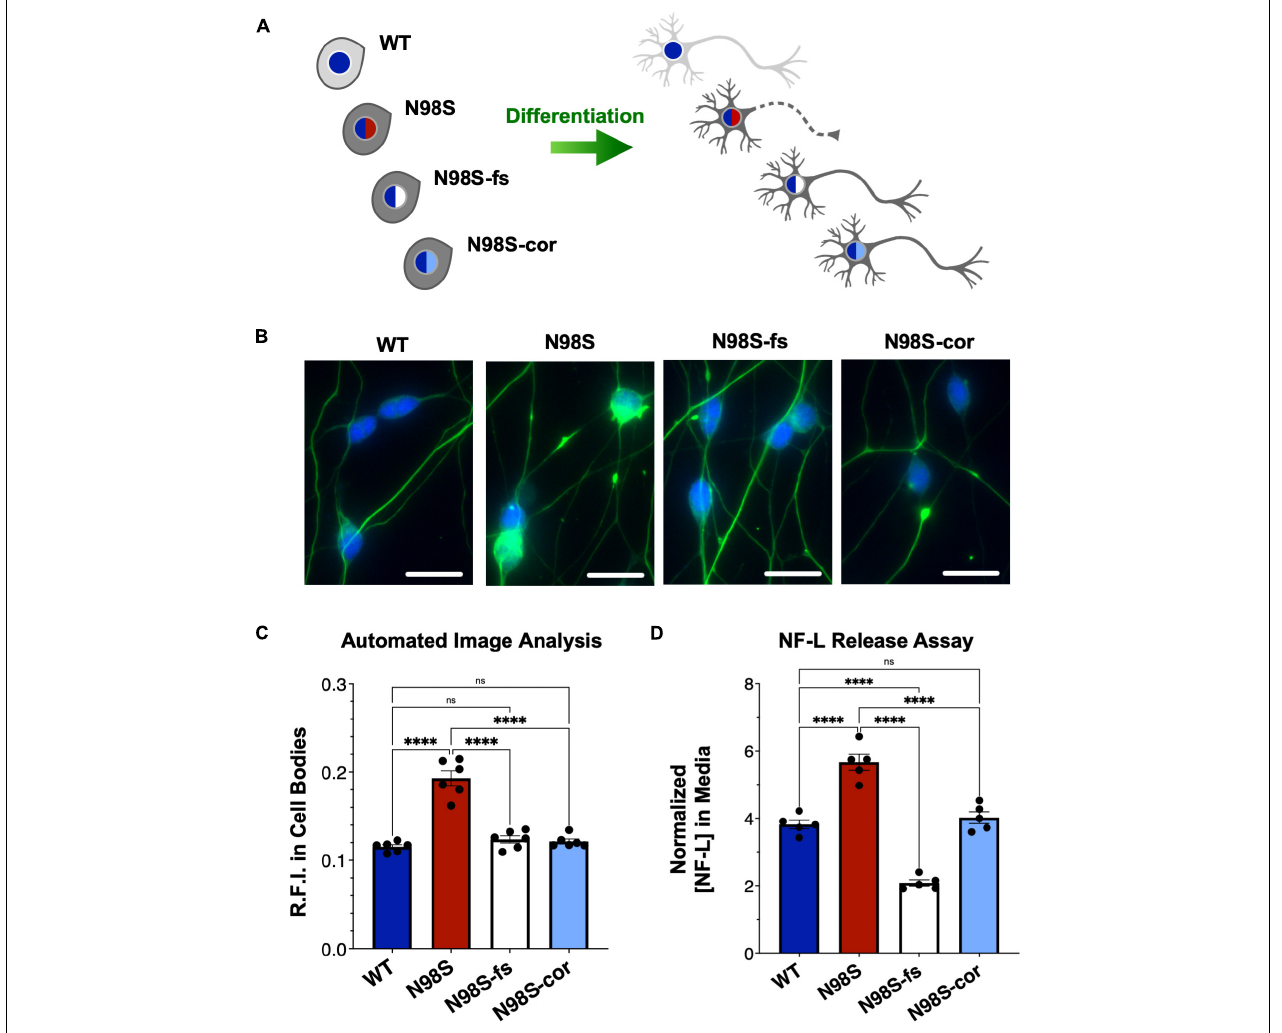
FIGURE 5 | Rescue of pathologic phenotypes in edited N98S motor neurons. (A) Schematic of allelic series of iPSCs differentiated into healthy (continuous axon) or diseased (dashed axon) i 3 LMNs. Colored nuclei represent NEFL genotypes as described in Figure 3 . Cytoplasmic shading indicates differential genetic backgrounds, dark gray cells are isogenic. (B) Representative images of day-7 i 3 LMNs stained with anti-NF-L (green) and anti-HB9 (blue) antibodies. Scale bars = 25 µ m. (C) Quantification of NF-L relative fluorescence intensity (R.F.I.) in HB9+ cell bodies using automated image analysis pipeline. Data points represent mean values from independent differentiations, bars indicate mean of six biological replicates ± S.E.M. (D) ELISA for NF-L protein in media from day-14 i 3 LMNs. NF-L levels were normalized to neurite density measurements to correct for well-to-well variability in cell seeding ( Supplementary Figure 8 ). Individual data points shown, bars indicate mean of five biological replicates ± S.E.M. For all graphs **** p < 0.0001 by one-way ANOVA with Šídák’s test for multiple